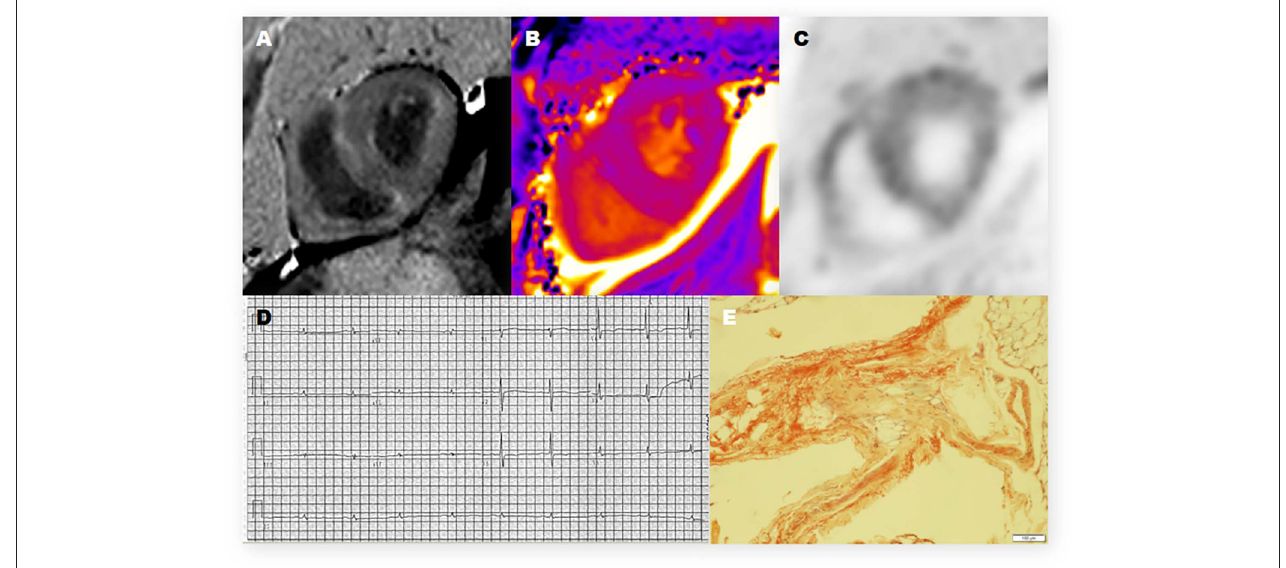
FIGURE 2 | Representative 11 C-PiB PET/MR, electrocardiogram, and histologic photomicrograph of one CA patient. (A) Late-gadolinium enhancement (LGE)-CMR image demonstrates a diffuse transmural enhancement pattern. (B) Native T1 mapping shows that the myocardial T1 value was 1,569ms. (C) The PET/MR image of the myocardium shows strong uptake of 11 C-PIB in the left ventricle (LV) and right ventricle (RV). (D) The electrocardiogram (12-lead) shows low voltage in the limb leads. (E) Histopathologic examination shows positive Congo red staining and amyloid deposits in the adipose tissue.